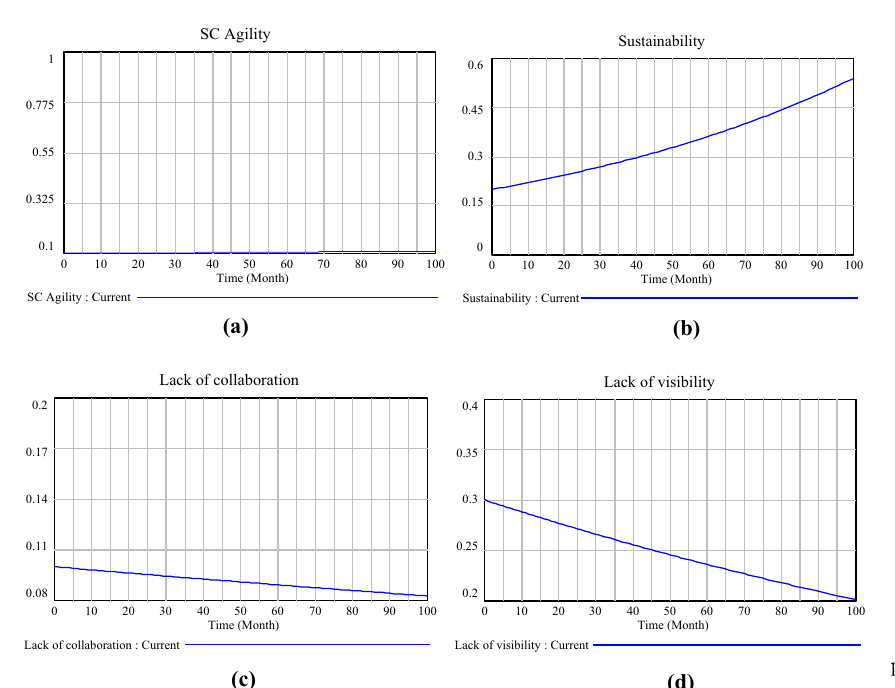
Figure 4. Stock and flow diagram for measuring resilience of